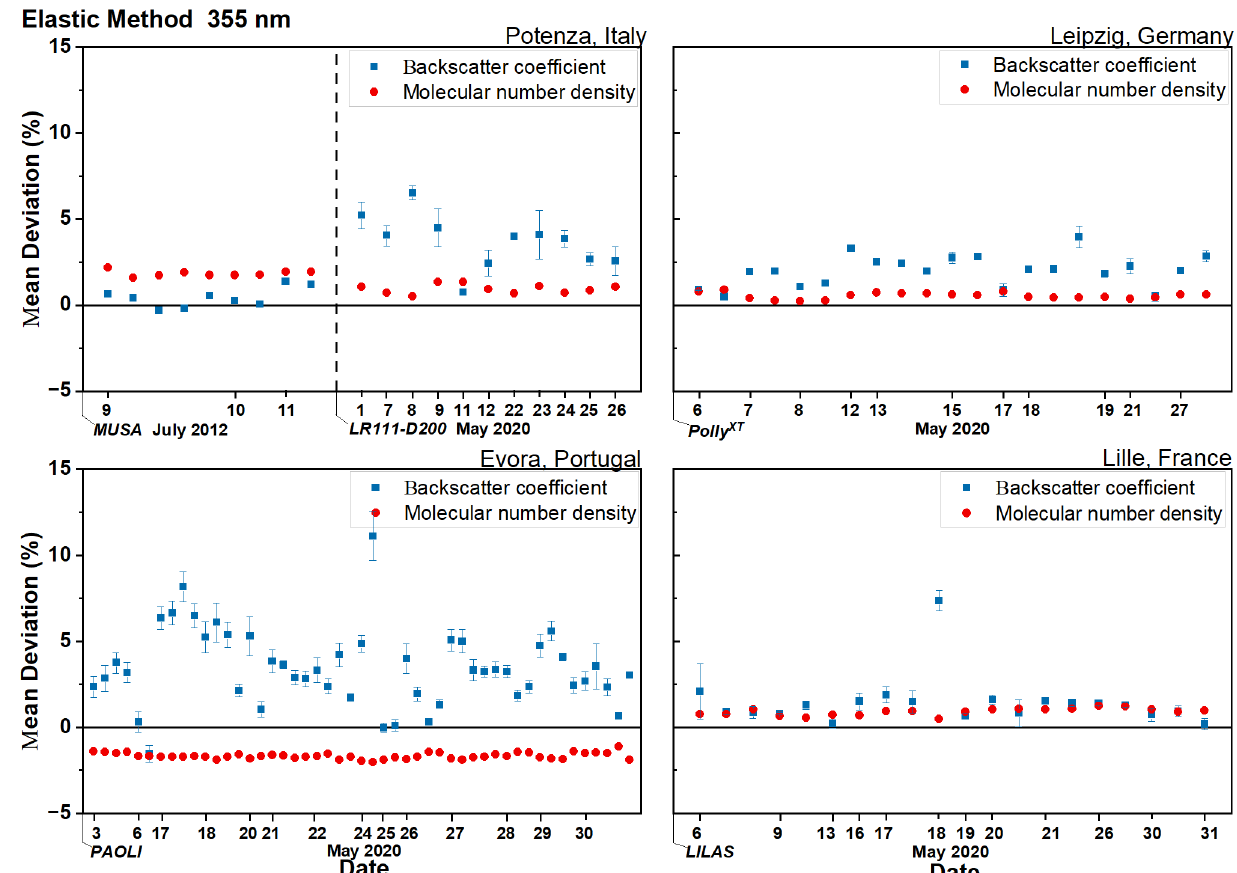
Figure 5. The mean relative deviations of elastic backscatter at 355 nm for all the four stations, whereas the deviation refers to the difference between the values calculated with ERA5 to the values calculated with forecast (IFS_ECMWF or GDAS). Blue and red dots represent the mean relative deviation of aerosol backscatter and molecular number density, respectively. The Date axis is not linear in time. It reports the dates (just one after the other) corresponding to the performed optical inversions. For example, for MUSA system (upper plot on the left) there are five optical inversions available for 9 July 2012 and two for 10 July 2012.